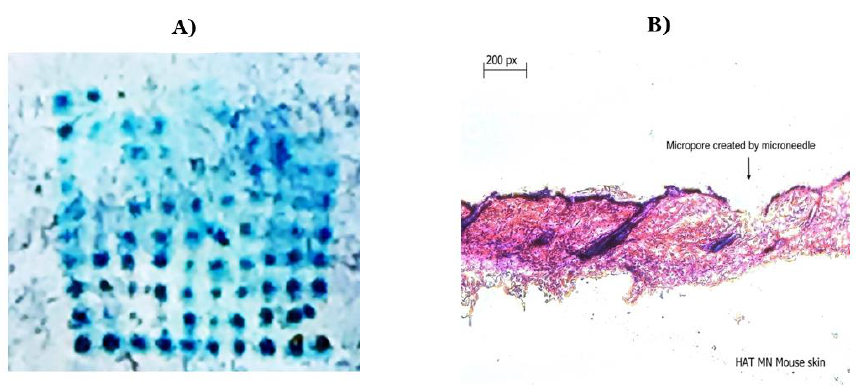
Figure 3. ( A ) Methylene blue staining after the application of microneedles on murine skin; ( B ) he- matoxylin and eosin staining of a transverse section of a microneedle applied to murine skin show- ing a formed micropore.